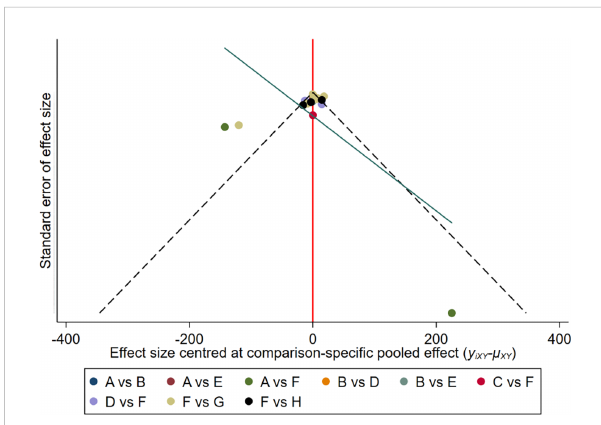
FIGURE 8 The comparison-adjusted ’ funnel plot of the changes in hepcidin of each intervention. A: Daprodustat; B: Darbepoetin; C: Desidustat; D: Enarodustat; E: Epoetin; F: Placebo; G: Roxadustat; H: Vadadustat.